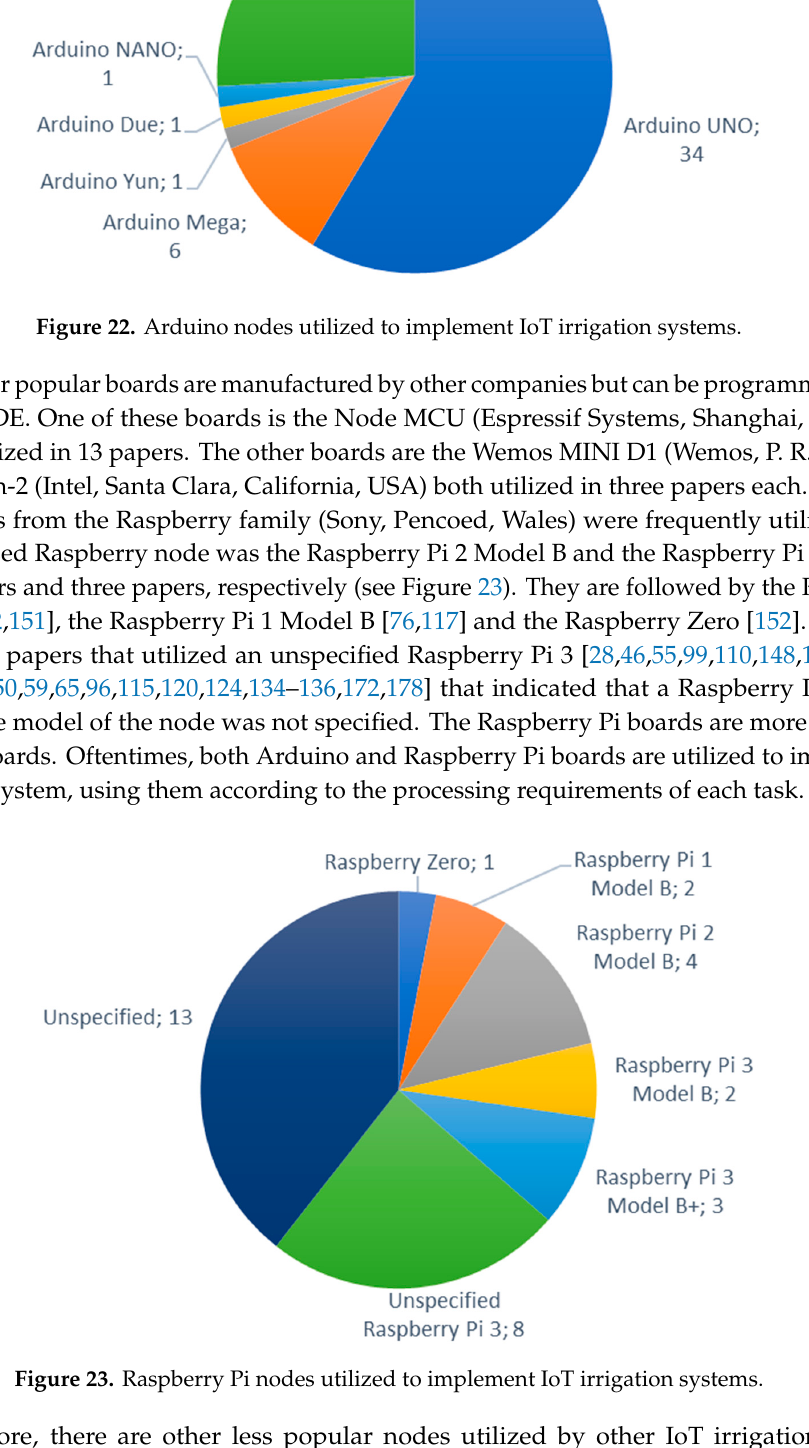
19 of 48 Figure 21. Most utilized nodes to implement IoT irrigation systems. Table 4. Most popular nodes for IoT irrigation systems. Node